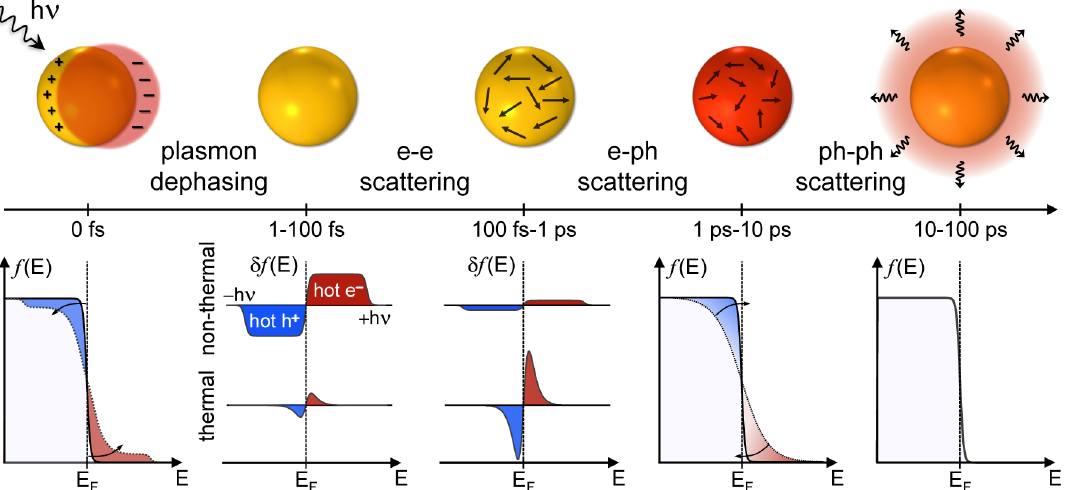
Figure 2: Photoinduced relaxation processes in a plasmonic nanostructure. Schematic representation of the relaxation processes following photoexcitation of a plasmonic NP. The main energy exchange mechanisms and characteristic time scales involved are indicated. The electronic distribution f ( E ) is also depicted, highlighting the non-thermal and thermal hot electrons (red) and holes (blue) contributions around the Fermi energy E F